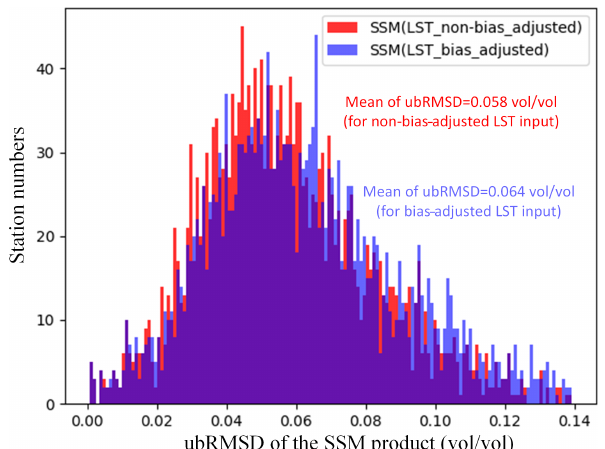
Figure B2. The statistical distribution of ubRMSD at different sta- tions for SSM estimates driven by two respective kinds of cloudy LST